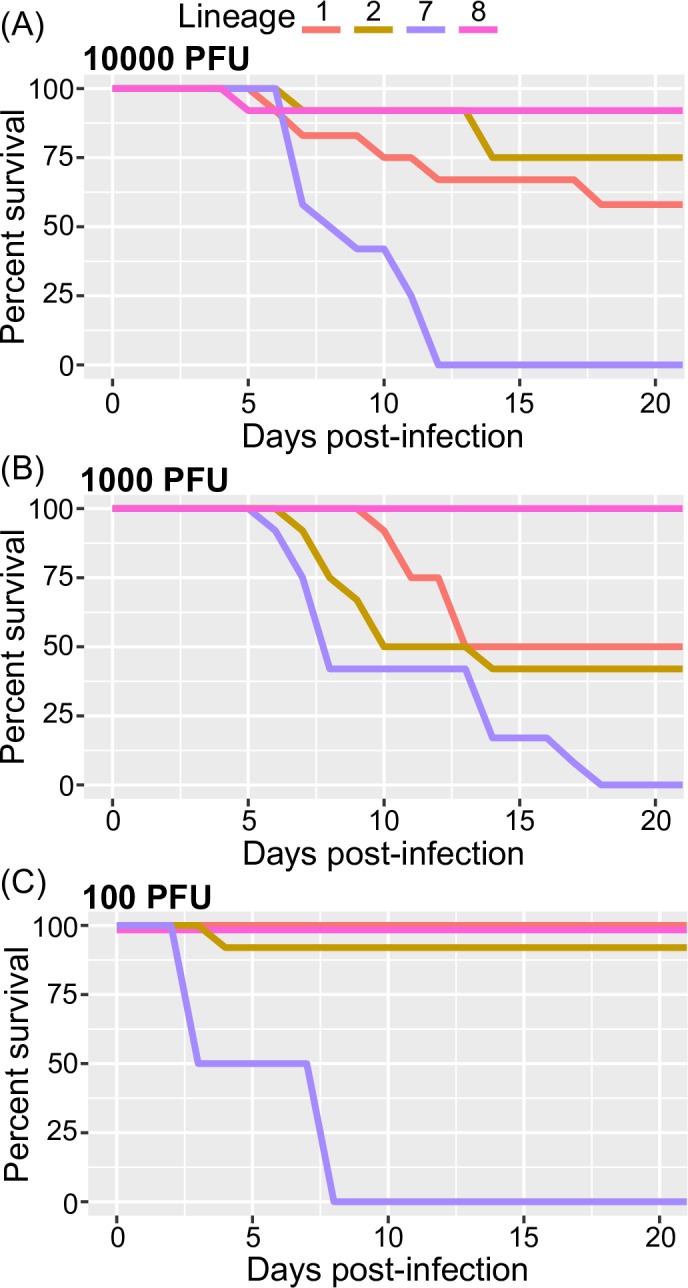
Survival curves of 5- to 6-week-old mice following intraperitoneal infection with (A) 10,000, (B) 1,000 and (C) 100 PFU. Mice were monitored daily for 21 days. Except in (C) when comparing lineage 8 and lineage 1, all survival curves were significantly different (Wilcoxon rank sum test, p-values < 0.05).